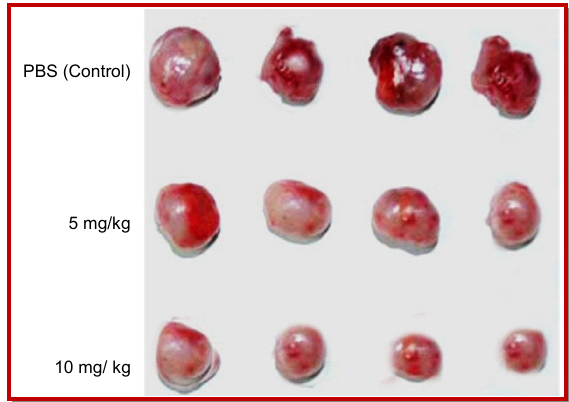
Figure 2: Effect of artemisinic acid on tumor growth in a mouse xenograft model. Images of cancerous tissues removed from the mice in control and drug-treated